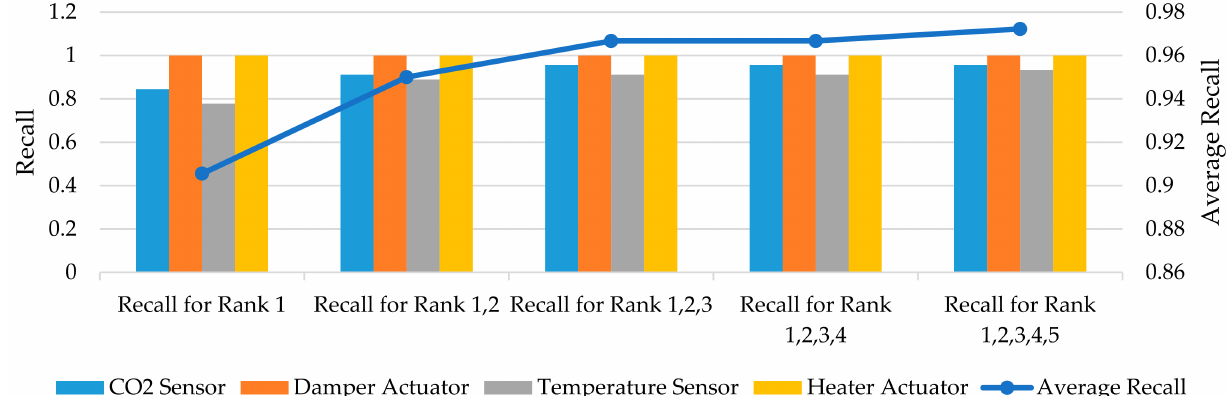
Figure 21. Recall and average recall in different ranks for different fault types.